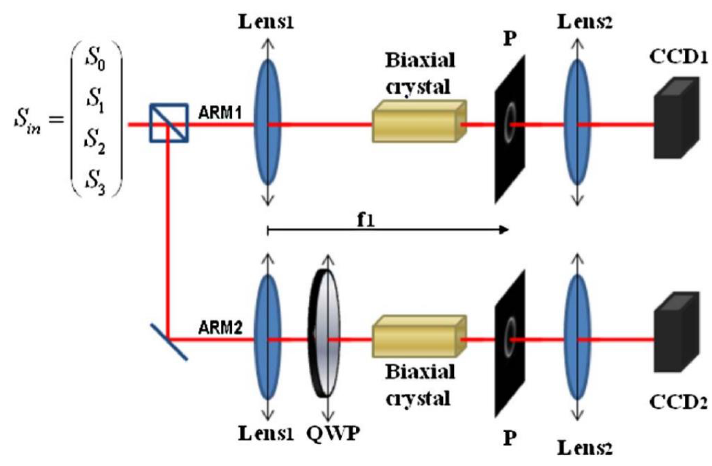
Figure 7. Schematic diagram of fractional amplitude polarization imaging [28].